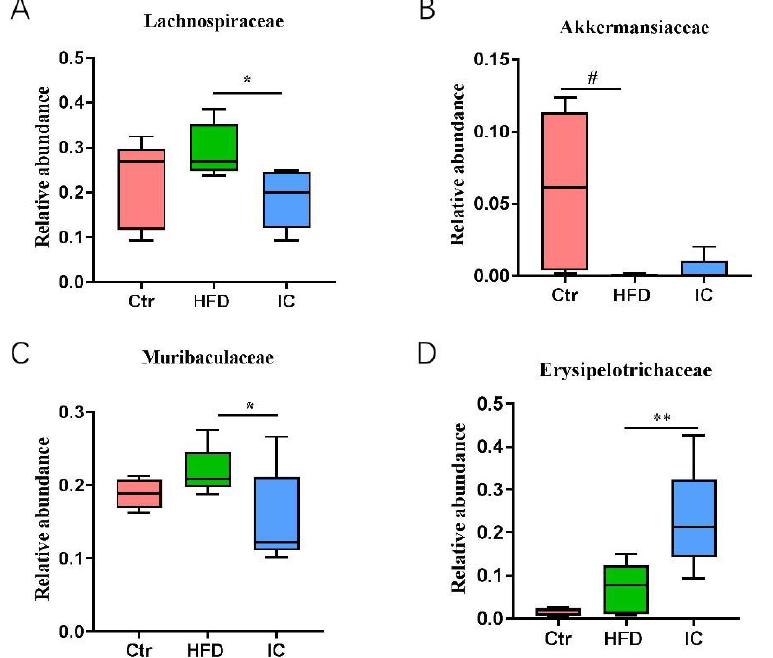
Figure 5. The relative abundance of four representative gut microbiota Lachnospiraceae ( A ), Akker- manisiaccae ( B ), Muribaculaceae ( C ) and Erysipelotrichaceae ( D ) compositions at the Family level. # ( p < 0.05),versus the control group; ** p < 0.01, * p < 0.05, versus the HFD group.